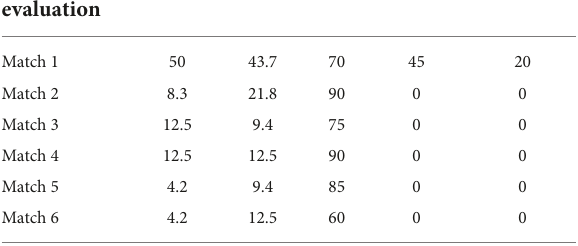
TABLE 7 Values in the POMS factors of Subject 4 after the matches. Time of evaluation